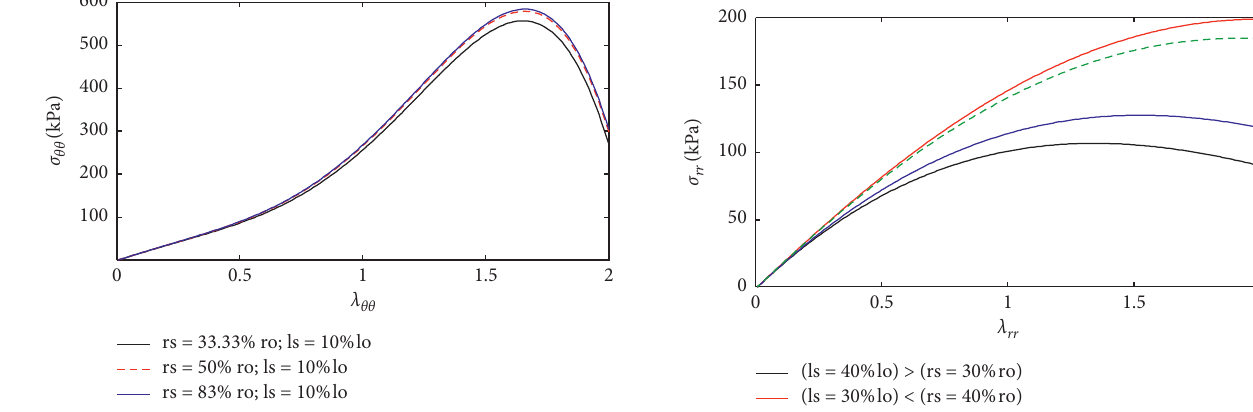
Figure 4: Study of the influence of the stenosis on the circum- ferential stress.